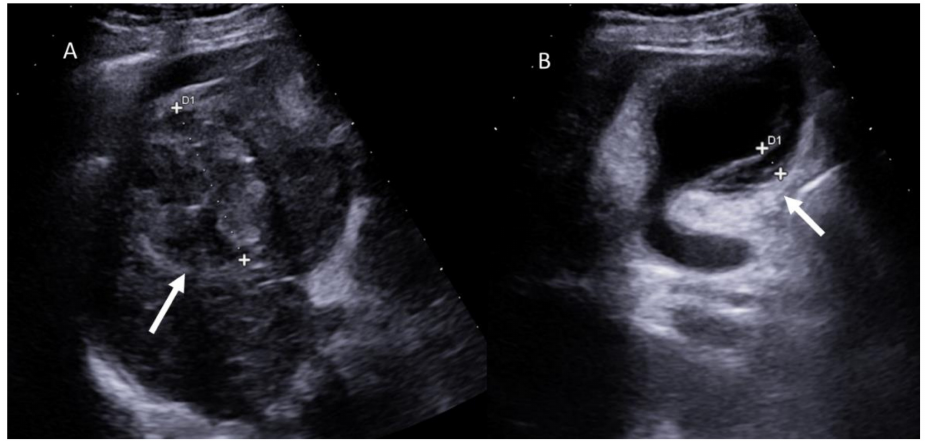
Figure 4. Ultrasound assessment of radio frequency treated HCC on V segment (( A ) arrow). In ( B ) arrow shows